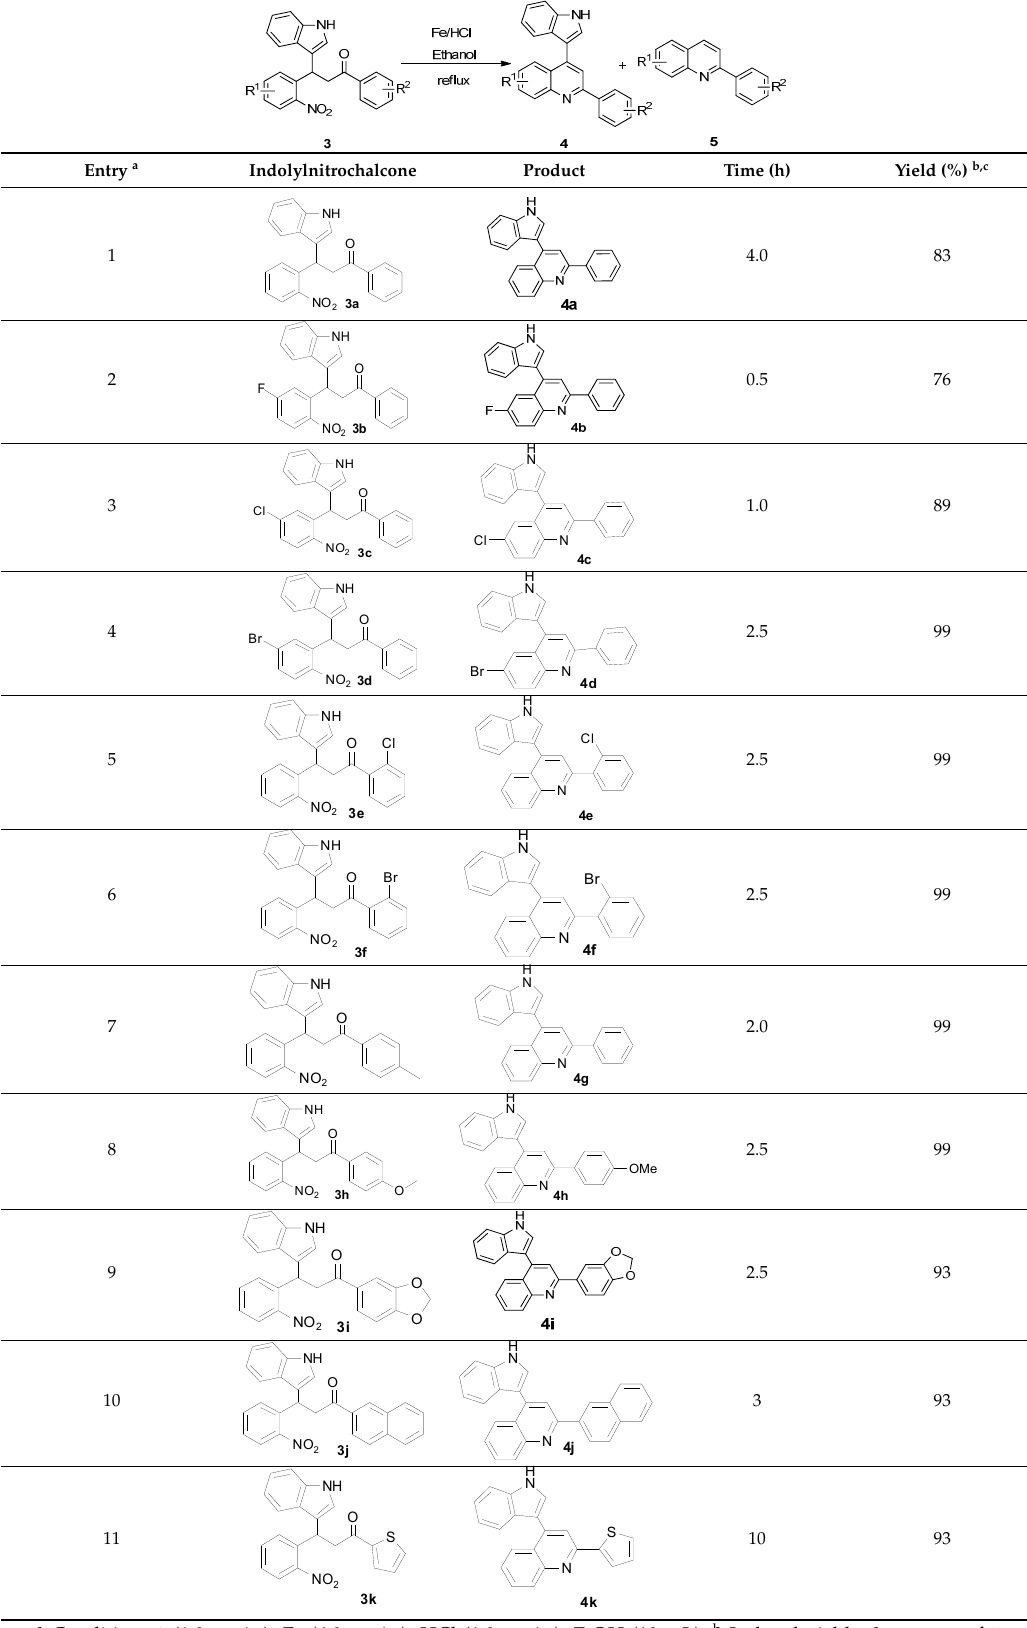
Table 4. Reductive cyclization of substituted 3-(1 H -indol-3-yl)-3-(2-nitrophenyl)-1-phenylpropan-1-one derivatives derived from various 2-nitrochalcone and indoles.